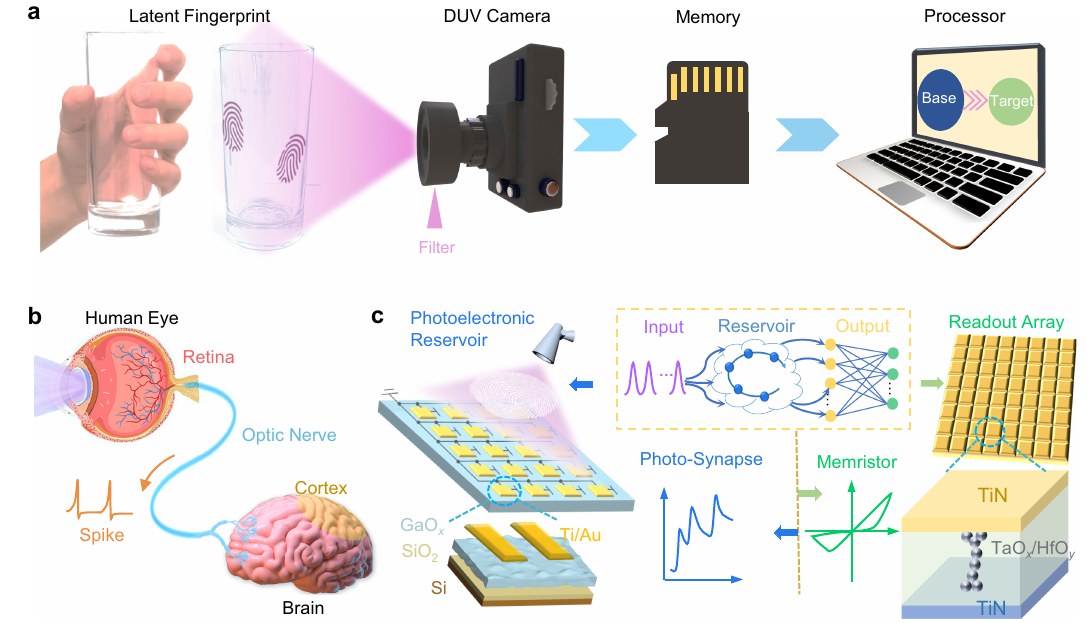
Fig. 1 | Reservoir computing system based on photo-synapse and memristor devicearray.a Dataprocessingmodeoftraditional fi ngerprintrecognitionsystem, realized by independent optical sensor, memory chip and processor. b Schematic ofthehumanvisualrecognitionsystemcomprisingtheretina,opticalneurons,and visualcortexinthehumanbrain. c ProposedRCsystemwithopticalsynapsesasthe inputlayerofthereservoirandthememristordevicearrayasthereadoutnetwork.